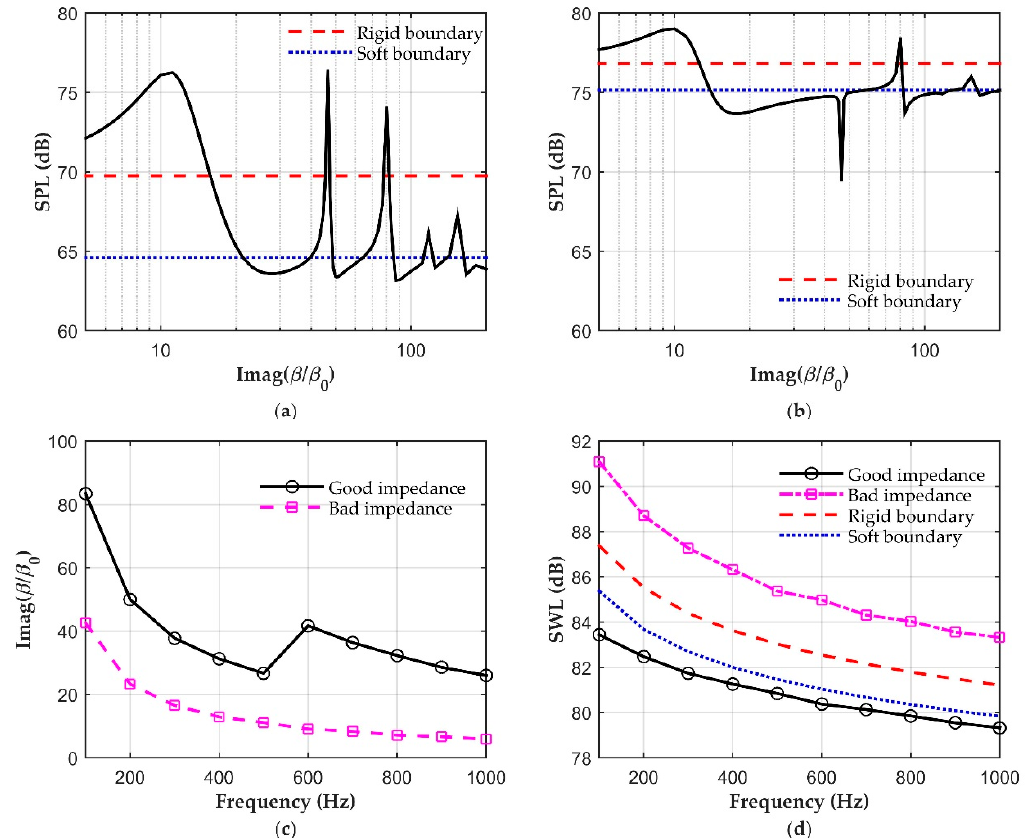
Figure 4. The good and bad top edge impedance: ( a ) The SPL curve at R 1 as a function of the imaginary part of top edge admittance; ( b ) the SPL curve at R 2 as a function of the imaginary part of top edge admittance; ( c ) the good and bad top edge impedance regarding the sound power flowing from Σ 2 to Space III; ( d ) the SWL flowing into the sound shadow zone under different boundary conditions.